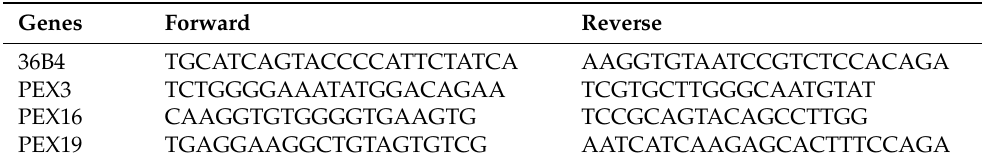
Table A1. Primer sequences used in the present